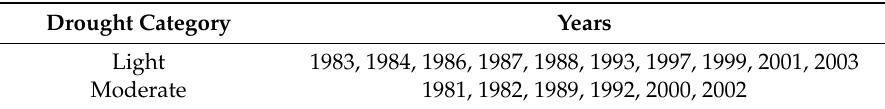
Table 2. Summary of drought events in Shandong Province from 1981 to